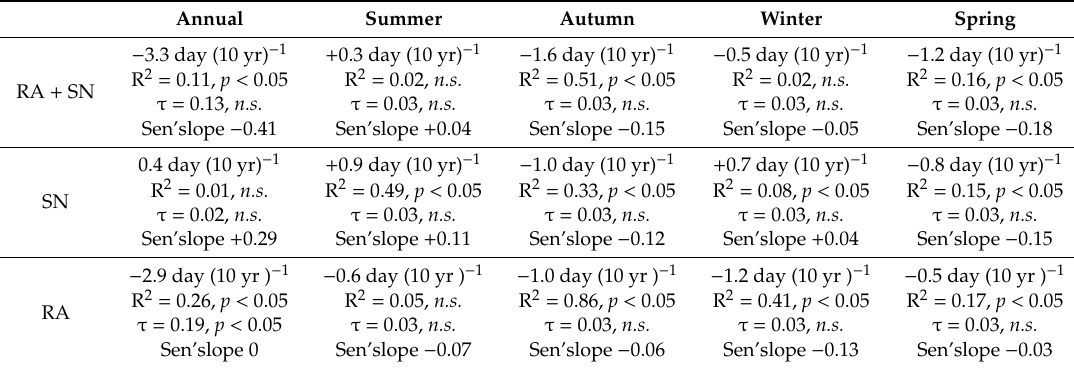
Figure 7. Annual ( a ) and seasonal ( b – e ) behavior of the total number of rain and snow precipitation events/days registered at Frei station for the 1970–2019 period. Dash lines are linear trends of the exponential filtered curves. Table 2. Statistic parameters of the trendlines (dashed lines) of Figure 7.